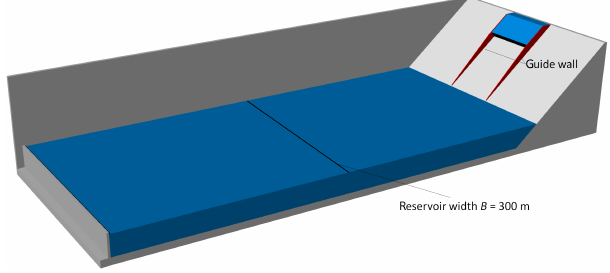
Figure 9. Initial condition for simulation with B = 300 and b = 80m; the guide walls are coloured in